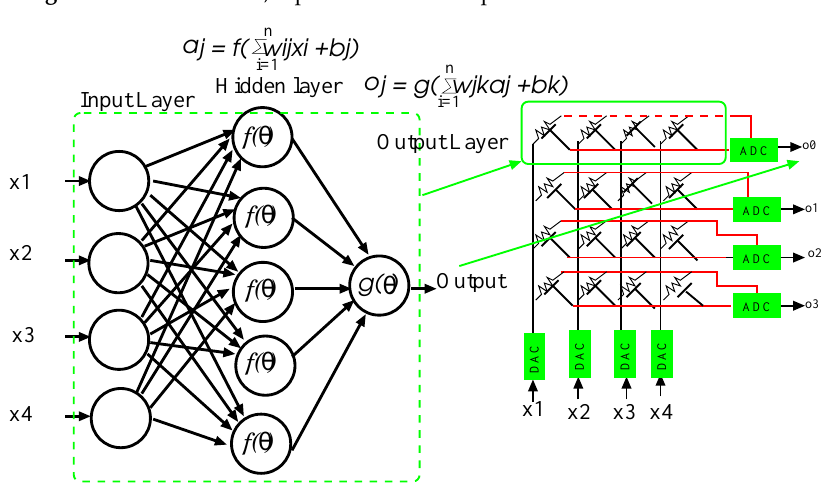
Figure 2. Basic CNN architecture and use of built-in computational